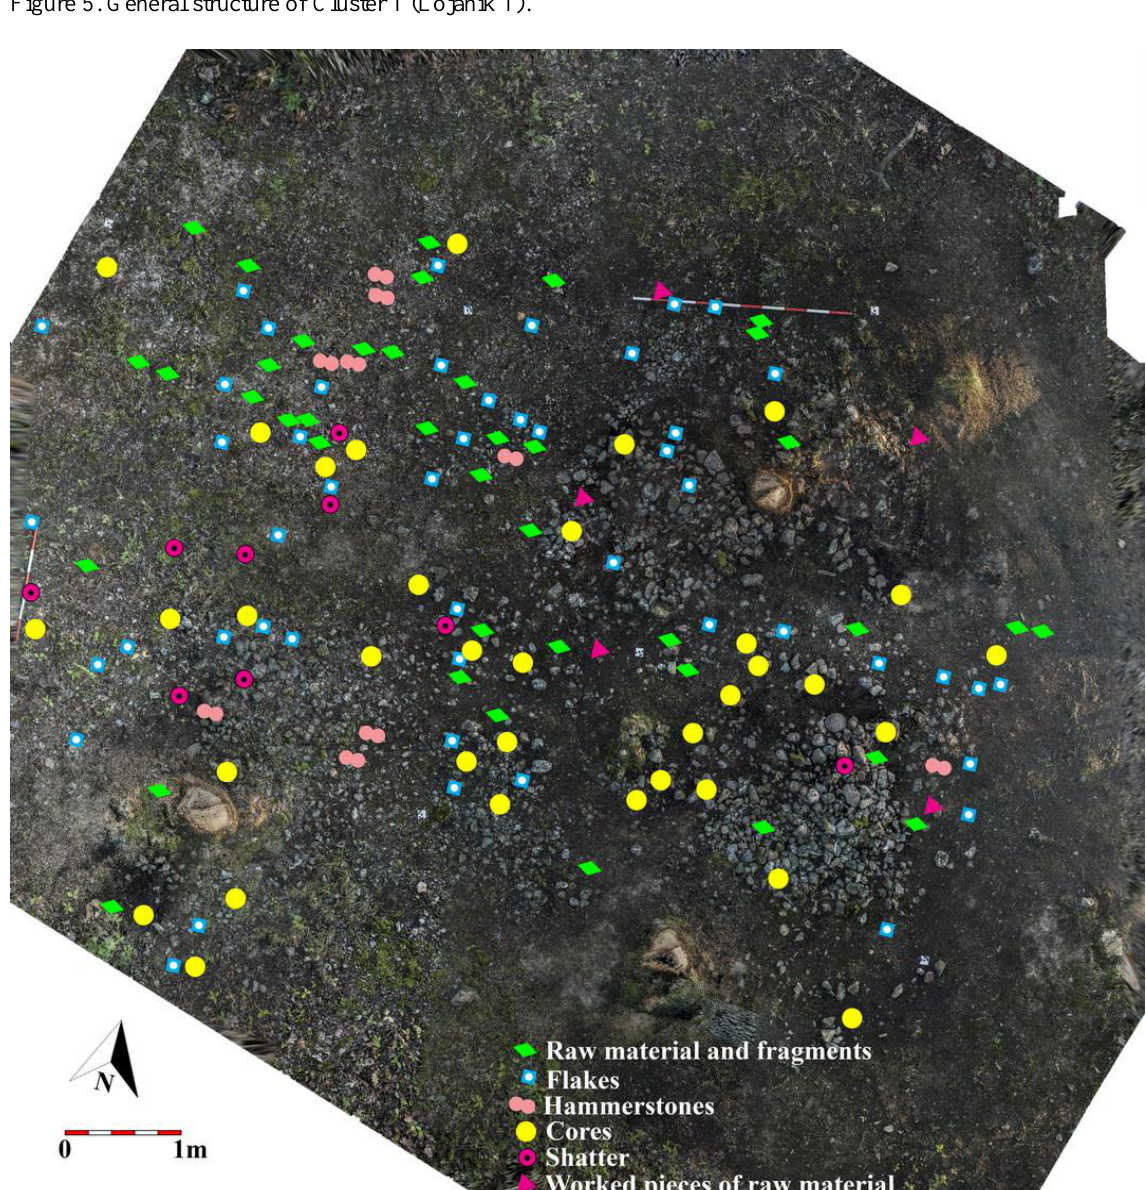
Figure 6. Cluster 1: Orthophoto with spatial distribution of main types of